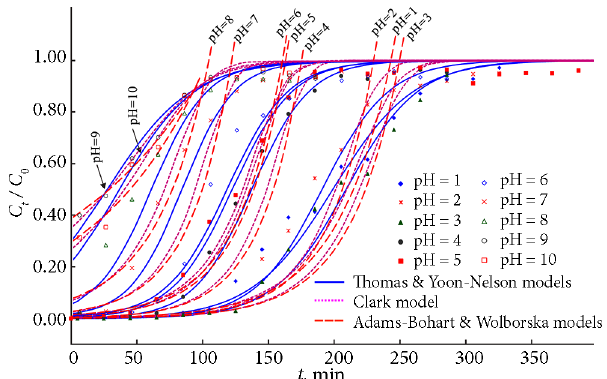
Figure 6. Effect of influent pH on breakthrough curve for As(V) adsorption removal by the PC-Fe/C adsorbent prepared with eucalyptus wood template (influent As(V) concentration: 20 mg/L; flow rate: 5.136 mL/min; adsorbent mass: 2 g; adsorbent grain size: <100 mesh; operating temperature: 35 °